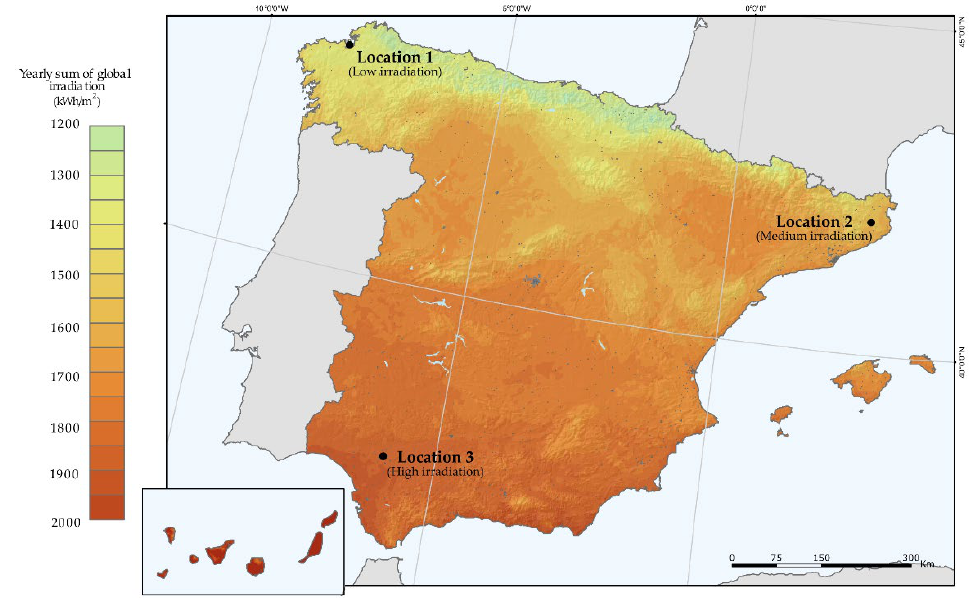
Figure 3. Irradiation map of Spain indicating the analyzed locations. Adapted from [33].